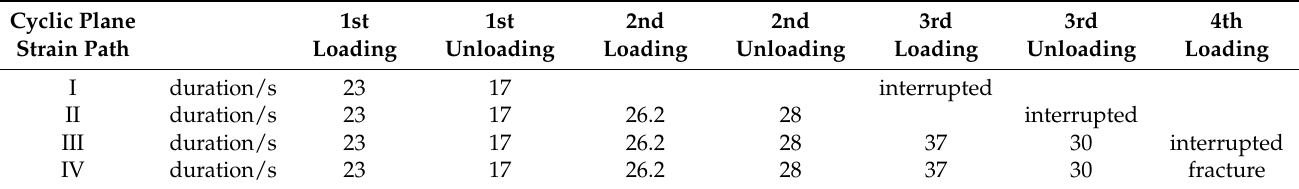
Figure 12. Comparison of cyclic plane strain loading and FE simulation: ( a ) Load-Stroke compari- son; ( b ) EPS comparison at the central surface deformation area.